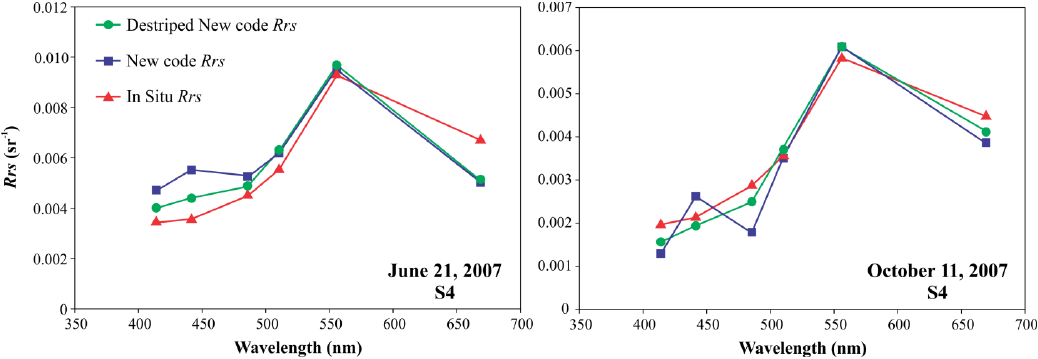
Figure 11. Comparison of in situ R and R estimated by the new code before and after rs rs destriping. In situ R was obtained with a hand-held hyperspectral radiometer and then rs weighted with the relative spectral response function of each OCM